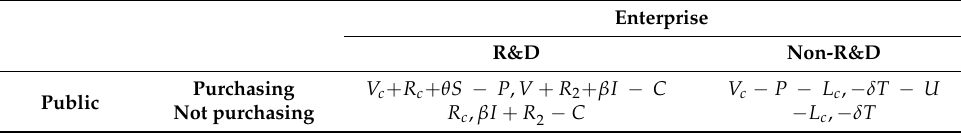
Table 2. The government-guided “enterprise–public” profit